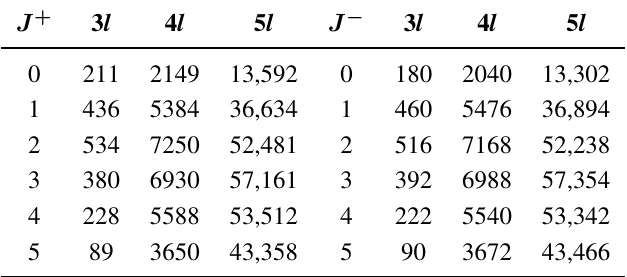
Table 1. Number of configuration state functions (CSFs) used in the atomic state function expansion for the given angular momentum and parity ( J P ) considering only quadruple